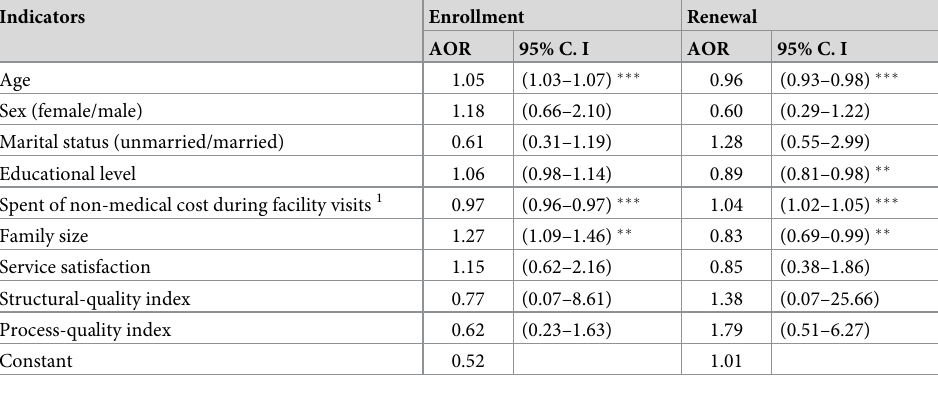
Table 6. Determinants of CBHI enrollment and renewal.